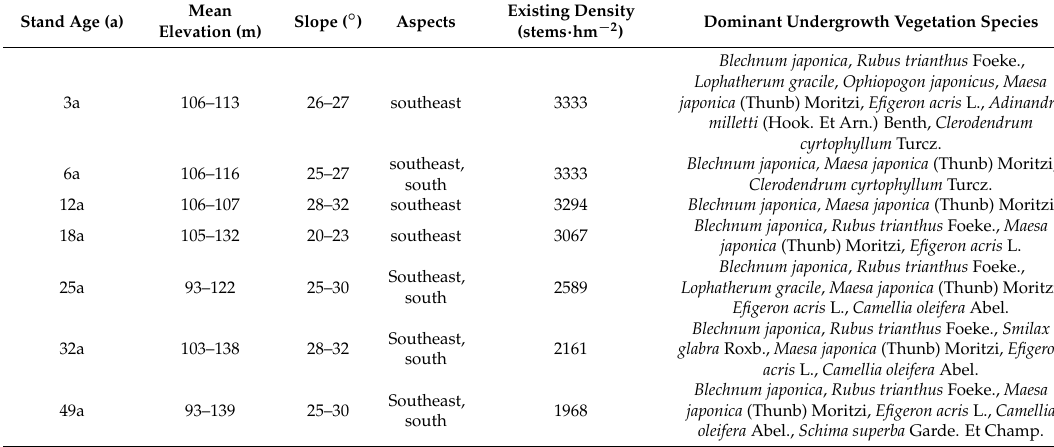
Figure 1. Locations of sampling blocks. Table 1. Characteristics of the plots of different ages.